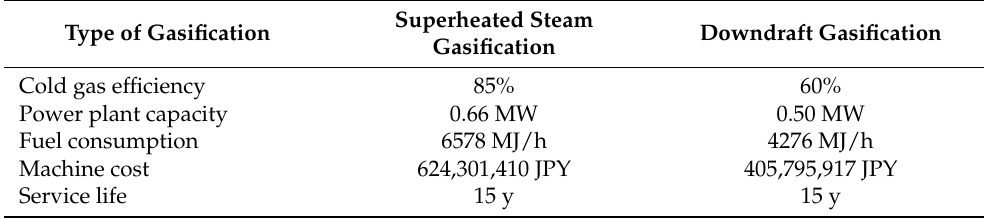
Figure 6. Gasification system specifications: ( a ) Fuel and power consumption over processing speed; ( b ) initial cost over processing speed. Table 3. Gasification specifications.